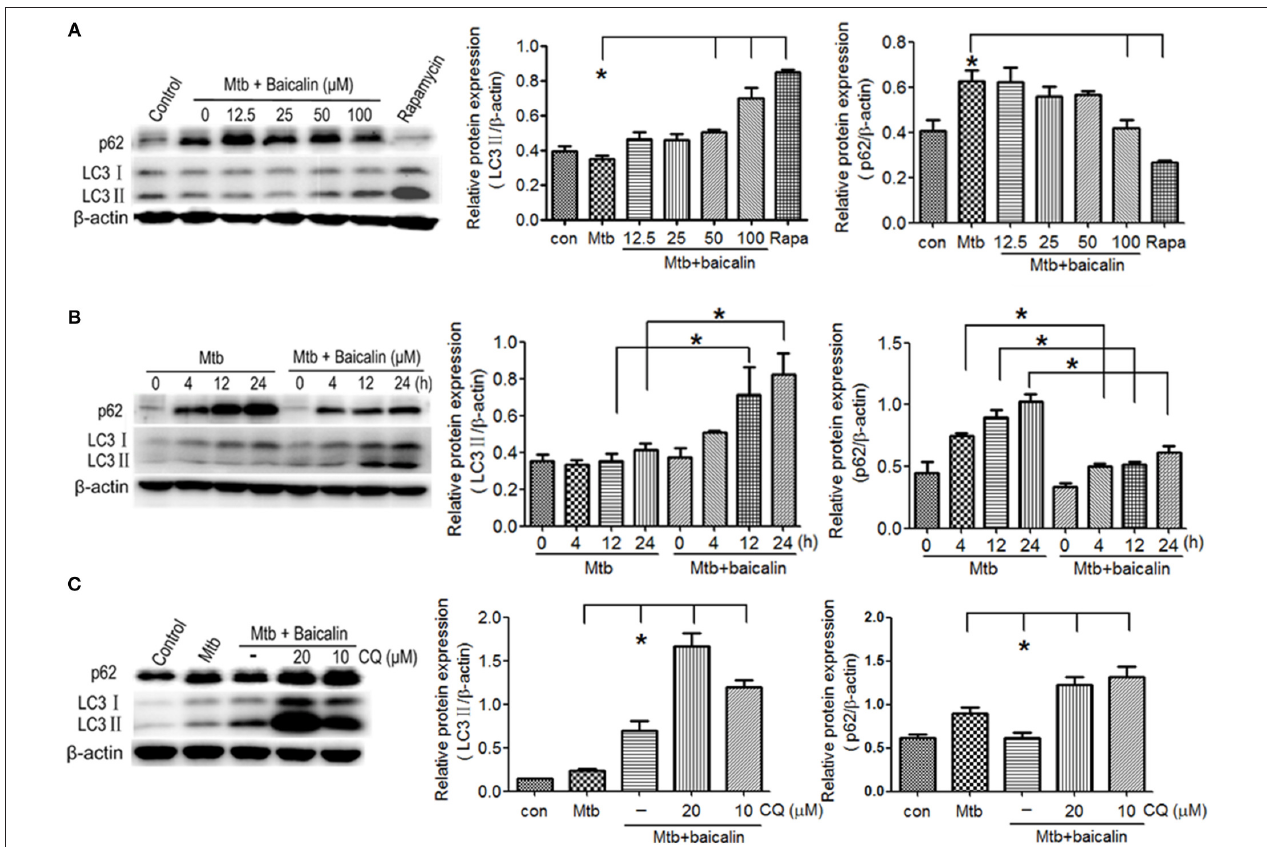
FIGURE 2 | Baicalin can promote the activation of autophagy in Mtb-infected macrophages. (A) Western blot analysis of LC3 I/II and p62 expression in Mtb-infected Raw264.7 cells after treatment with different concentrations of baicalin (0, 12.5, 25, 50, 100 µ M) or rapamycin (1 µ g/ml) for 12h. The right bar graphs show the statistical results for the relative quantitative expression of LC3 II and p62. (B) Western blot analysis of LC3 I/II and p62 expression in Mtb-infected Raw264.7 cells. After different times of Mtb infection (0, 4, 12, 24h), cells were treatment with or without baicalin (100 µ M). The right bar graphs showed the statistical results for the relative quantitative expression of LC3 II and p62. ( C) Western blot analysis of LC3 I/II and p62 expression in Mtb-infected Raw264.7 cells after treatment with baicalin (100 µ M) or CQ (10, 20 µ M) for 12h. The right bar graphs showed the statistical results for the relative quantitative expression of LC3 II and p62 expression. Data are shown with the means ± SD of at least three independent experiments. * p <